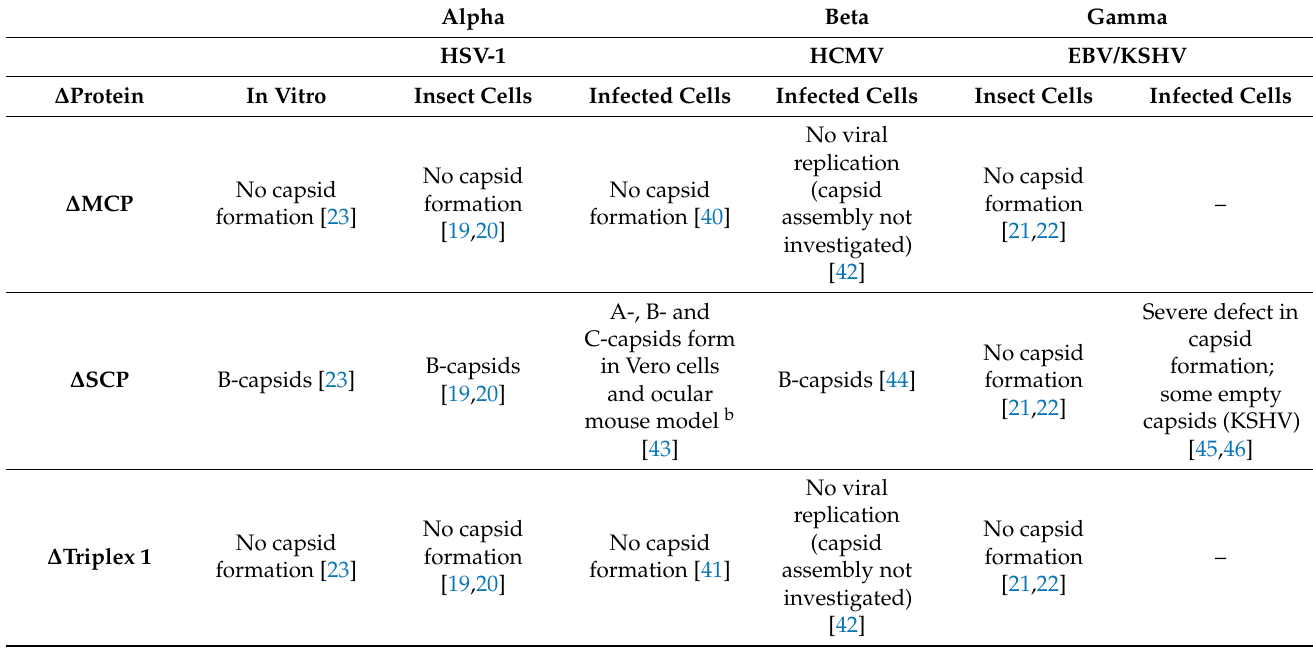
Table 2. Comparison of the effects on capsid assembly in the absence of specific capsid shell proteins (e.g., ∆ MCP) across human herpesvirus subfamilies under different experimental conditions (in vitro, in insect cells infected with recombinant baculoviruses, or in herpesvirus-infected cells). Boxes with dashed lines indicate a lack of published